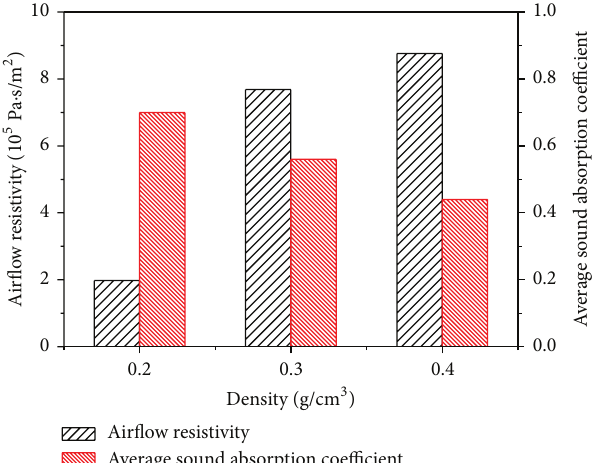
Figure 5: The relationship between the average sound absorption coefficient and airflow resistivity of the composites of different densities.